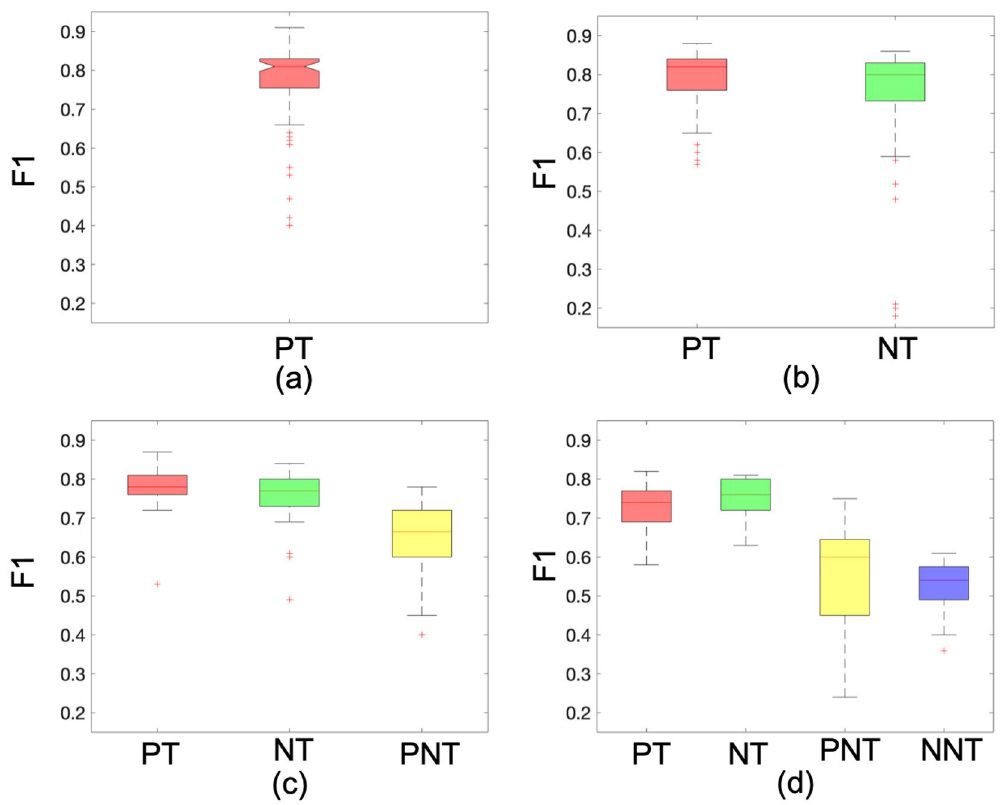
Figure 5. Distribution of F1 among different cell categories and competition levels. ( a ) Mild level; ( b ) Hot level; ( c ) Spicy level; ( d ) Supercharger level. (PT: Positive Tumour; NT: Negative Tumour; PNT: Positive Non-Tumour; NNT: Negative Non-Tumour).